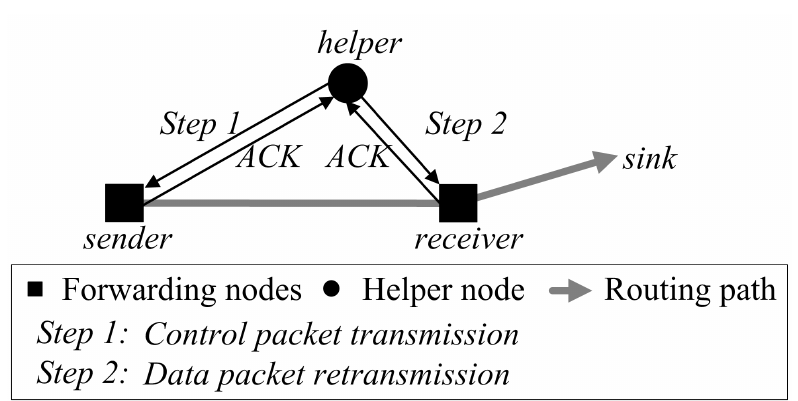
Figure 3. Retransmission of the helper